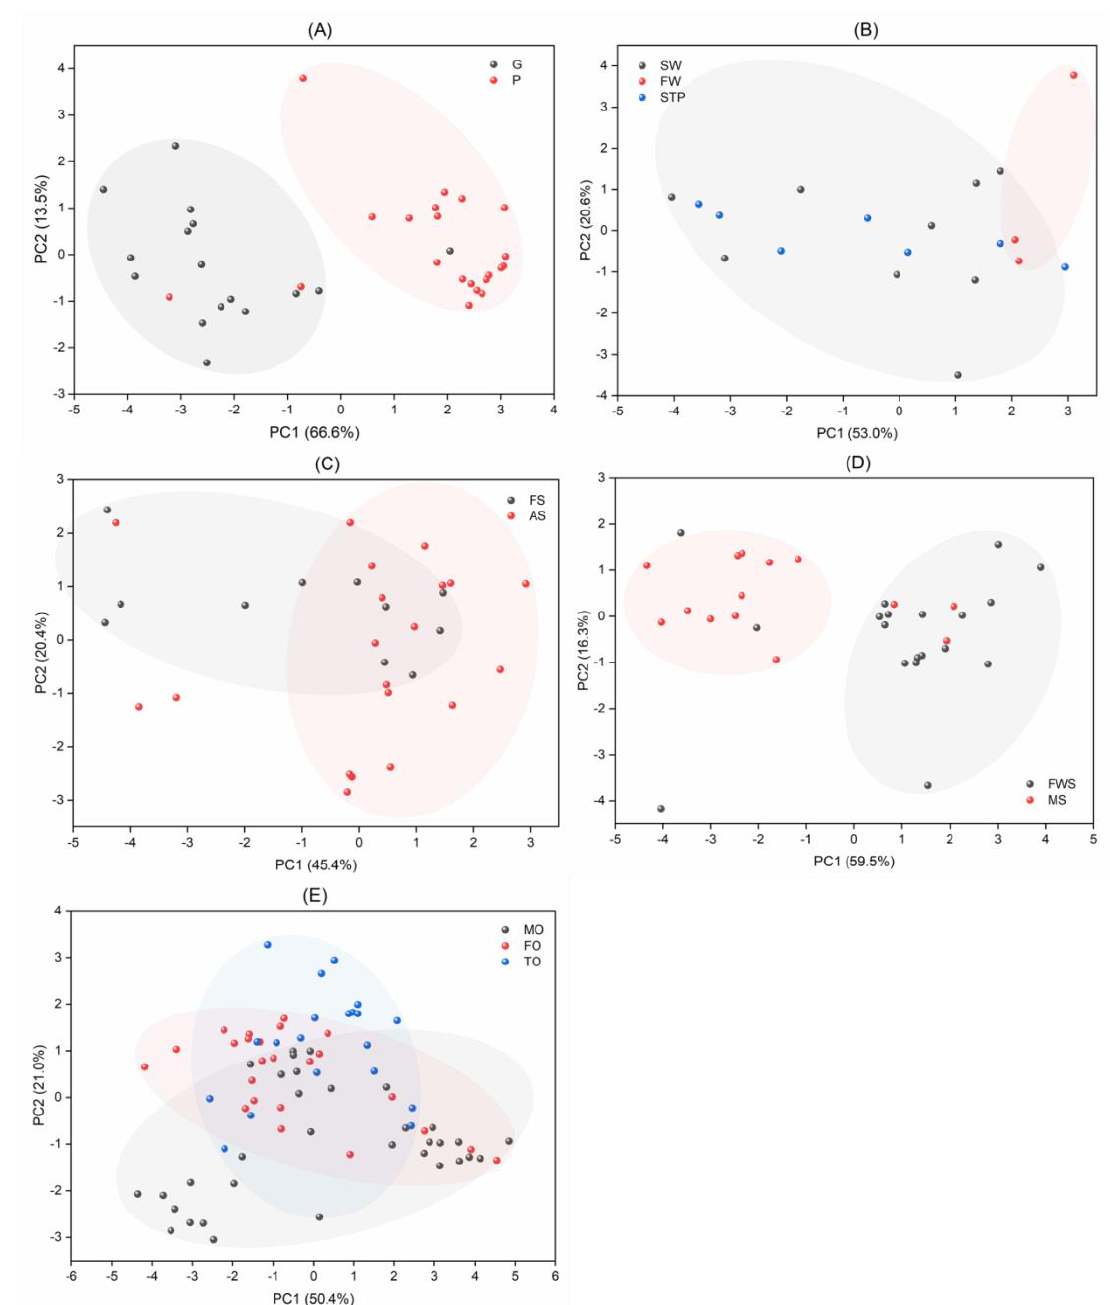
Figure 5. PCA of SCCP congeners in different environmental matrices in China. ( A ) PCA of SCCP congeners in air (G: gas phase; P: particle phase). ( B ) PCA of SCCP congeners in water (SW: seawater; FW: freshwater; STP: wastewater from sewage treatment plant). ( C ) PCA of SCCP congeners in soil (FS: farmland soil; AS: ambient soil). ( D ) PCA of SCCP congeners in sediment (FWS: freshwater sediment; MS: marine sediment). ( E ) PCA of SCCP congeners in biota (MO: marine organism; FO: freshwater organism; TO: terrestrial organism).